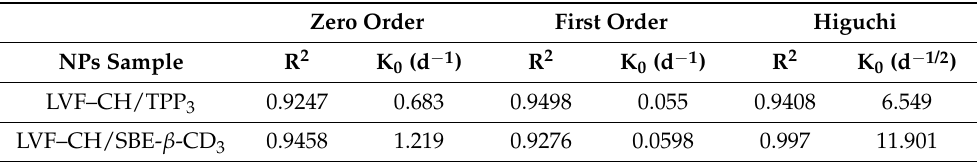
Table 5. Regression coefficient (R 2 ) and rate constant (K) of LVF release data from LVF–CH/TPP 3 NPs and LVF–CH/SBE- β -CD 3 NPs according to different kinetic models.